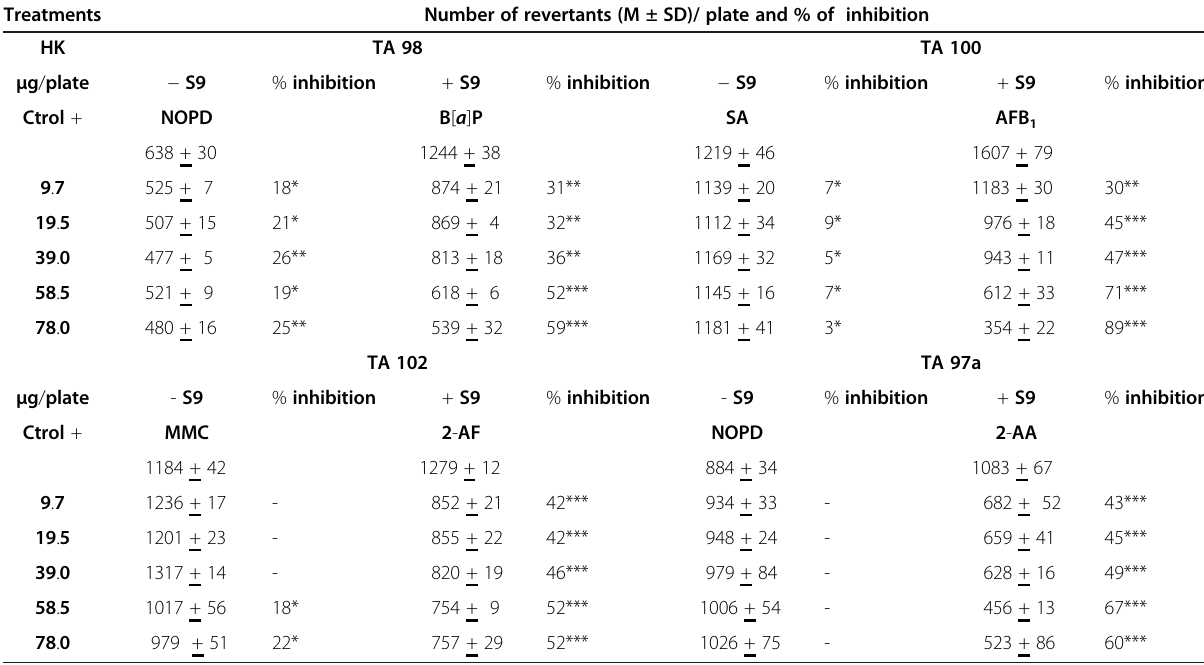
Table 3 Antimutagenic activity expressed as the mean and standard deviation of number of revertants and percent inhibition by HK of direct ( − S9) and indirect (+S9) mutagens, tested on strains TA98, TA100, TA102 and TA 97a of S . typhimurium Treatments Number of revertants (M ± SD)/ plate and % of inhibition HK TA